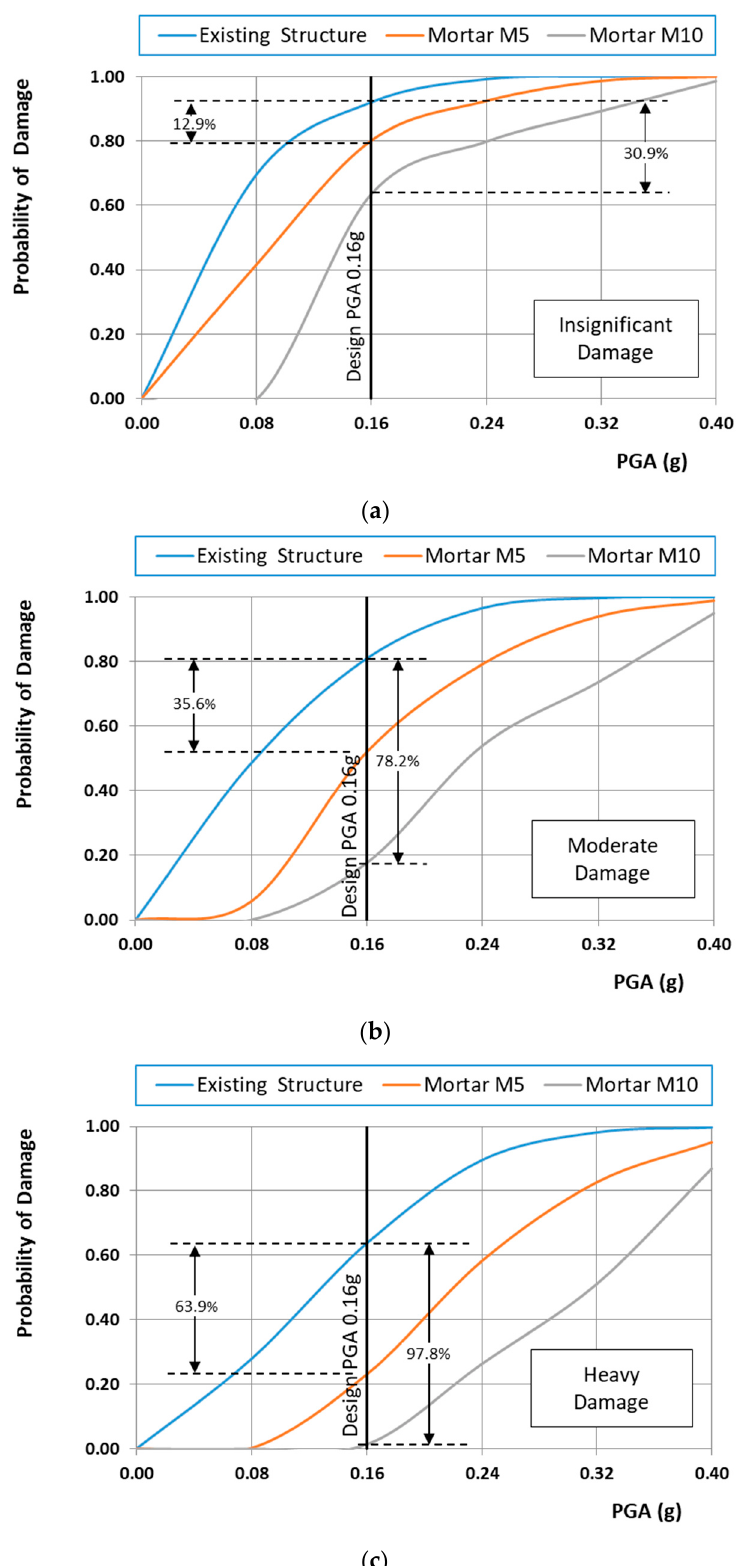
Figure 12. Fragility curves of existing structure normal distribution: ( a ) normal distribution; ( b ) lognormal distribution.